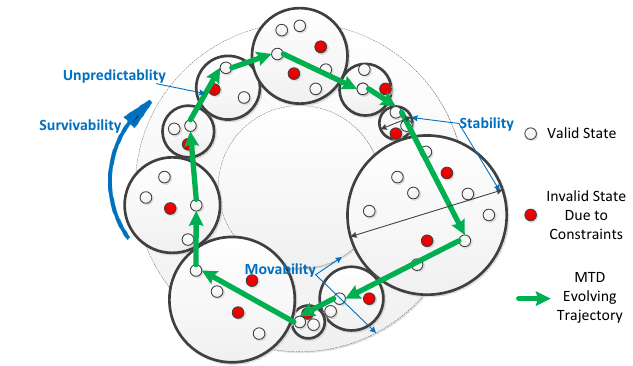
Figure 3. The MTD self-evolving loop with evaluation metrics multiple types of vulnerabilities of di ff erent impacts.